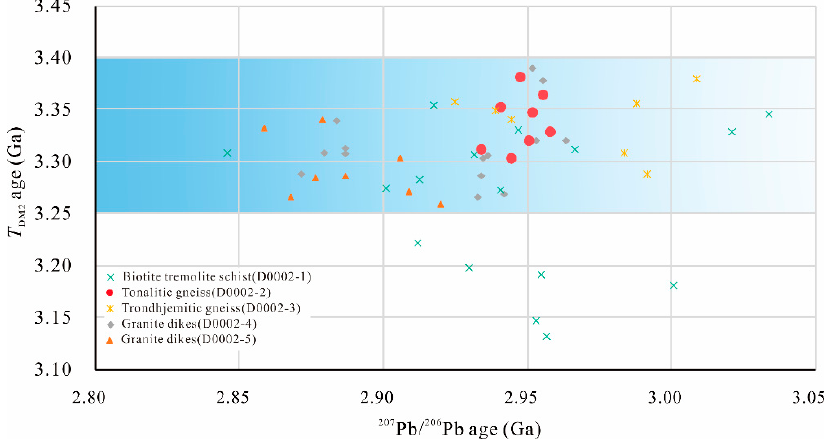
Figure 20. T DM2 age versus 207 Pb / 206 Pb zircon age diagram for the biotite–tremolite schists, tonalitic gneisses, trondhjemitic gneisses, and granitic dikes.